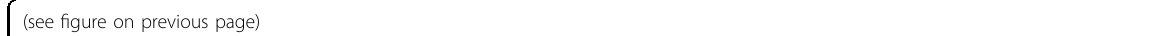
Fig. 3 Moda fi nil rescues ovariectomy-induced impairments of hippocampal basal transmission and long-term potentiation in hippocampal slices ex vivo. a At the end of sleep recordings, the hippocampus of each animal was separated for electrophysiological experiments. b Diagram of a hippocampal slice showing the placement of electrodes. The stimulation electrodes (red, S1, S2) were placed in the stratum radiatum (str. rad.) area of the hippocampal CA1 region. A recording electrode (green, Rec) was placed in between to record fi eld excitatory postsynaptic potentials (fEPSPs) evoked by extracellular stimulation of Schaffer collaterals by the S1 input. The S2 input was used as a control input to monitor baseline stability. c Representative traces of fEPSPs obtained after a set of consecutive stimuli. d The input-output relationship of basal synaptic transmission was obtained by plotting the slope of fEPSPs against stimulation intensity in different groups of mice. e Sample fEPSP traces of paired- pulse facilitation (PPF, ratios of the second fEPSP and the fi rst fEPSP obtained at different interstimulus intervals). f PPF was obtained in different groups of mice. * p < 0.05 versus Sham + Vehicle (Veh) group; # p < 0.05 versus OVX + Veh group assessed by Mann – Whitney U tests in ( d ) and ( f ). g Schematic representation of the stimulation protocols used for the induction of long-term potentiation (LTP). Two trains of theta-burst stimulation (TBS) with a 30-s inter-train interval were delivered to induce LTP. h Sample traces of fEPSPs at 0, 5, and 180 min (marked as 1, 2, and 3, respectively). i Time courses of normalized initial slope measurements of fEPSPs. Every data point represented the averaged data of four consecutive sweeps with an interval of 10 s. LTP was evoked by TBS indicated by black arrowheads. * p < 0.05 versus Sham + Veh group; # p < 0.05 versus OVX + Veh group. The black horizontal bars cover all the signi fi cantly different time points. N indicates the numbers of animals, while n indicates the numbers of slices. The non-tetanized baseline recording by input S2 remained stable in the different groups.